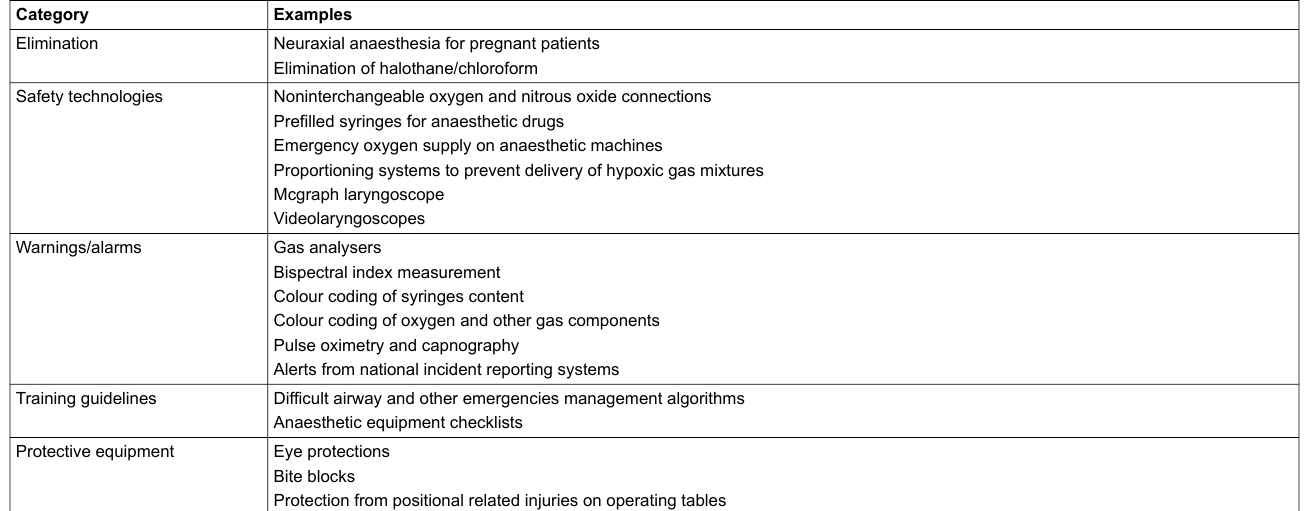
Table 1: Classification of anaesthesia risk management strategies according to the safety hierarchy model.